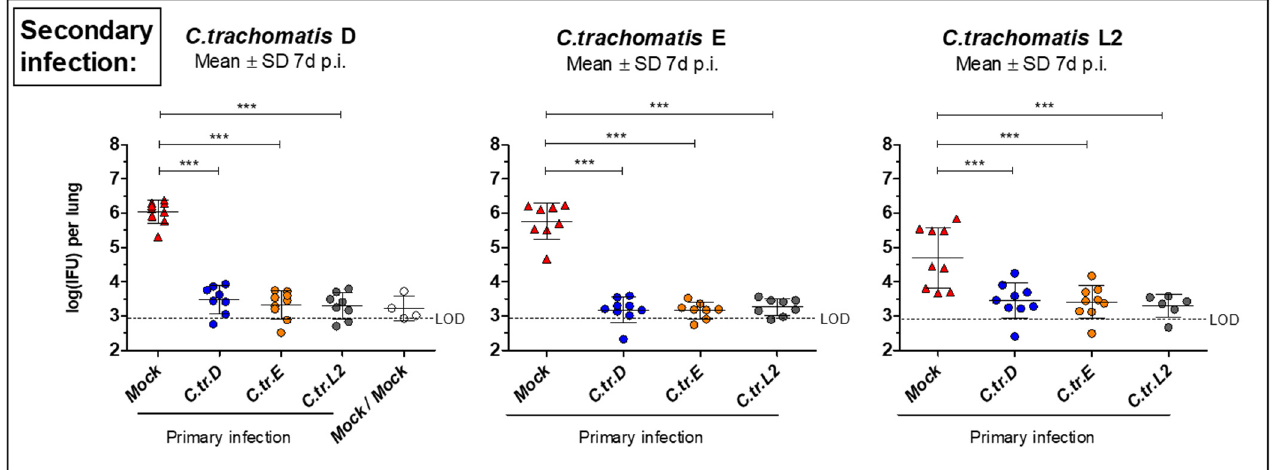
Figure 3. Mice i.n. reinfected with C.tr. serovars D, E, and L2 show similar improved bacterial clearance after recovery from a lung infection with either of the three serovars. With C.tr. genital serovars D, E or L2 or mock material, pre-challenged animals were infected i.n. again with the C.tr. serovars D (left panel), E (middle panel) or L2 (right panel) 7 weeks after the first infection. Mice twice infected with mock material served as negative control. Seven days after the secondary i.n. infection with C.tr. serovars D, E or L2, mice were painlessly sacrificed and bacterial load—i.e., the amount of viable, infectious bacteria (left to right panel, mean ± SD of log 10 (IFU))—was determined. LOD = limit of detection. The performed statistical analysis is described in Section 2. Group sizes were n = 8–9 with the exception of n = 6 for C.tr. L2/ C.tr. L2, and n = 4 for Mock/Mock. *** indicates statistical significances between the previously mock-infected (red) animal groups and groups initially infected with C.tr. D, E or L2 with p < 0.001.